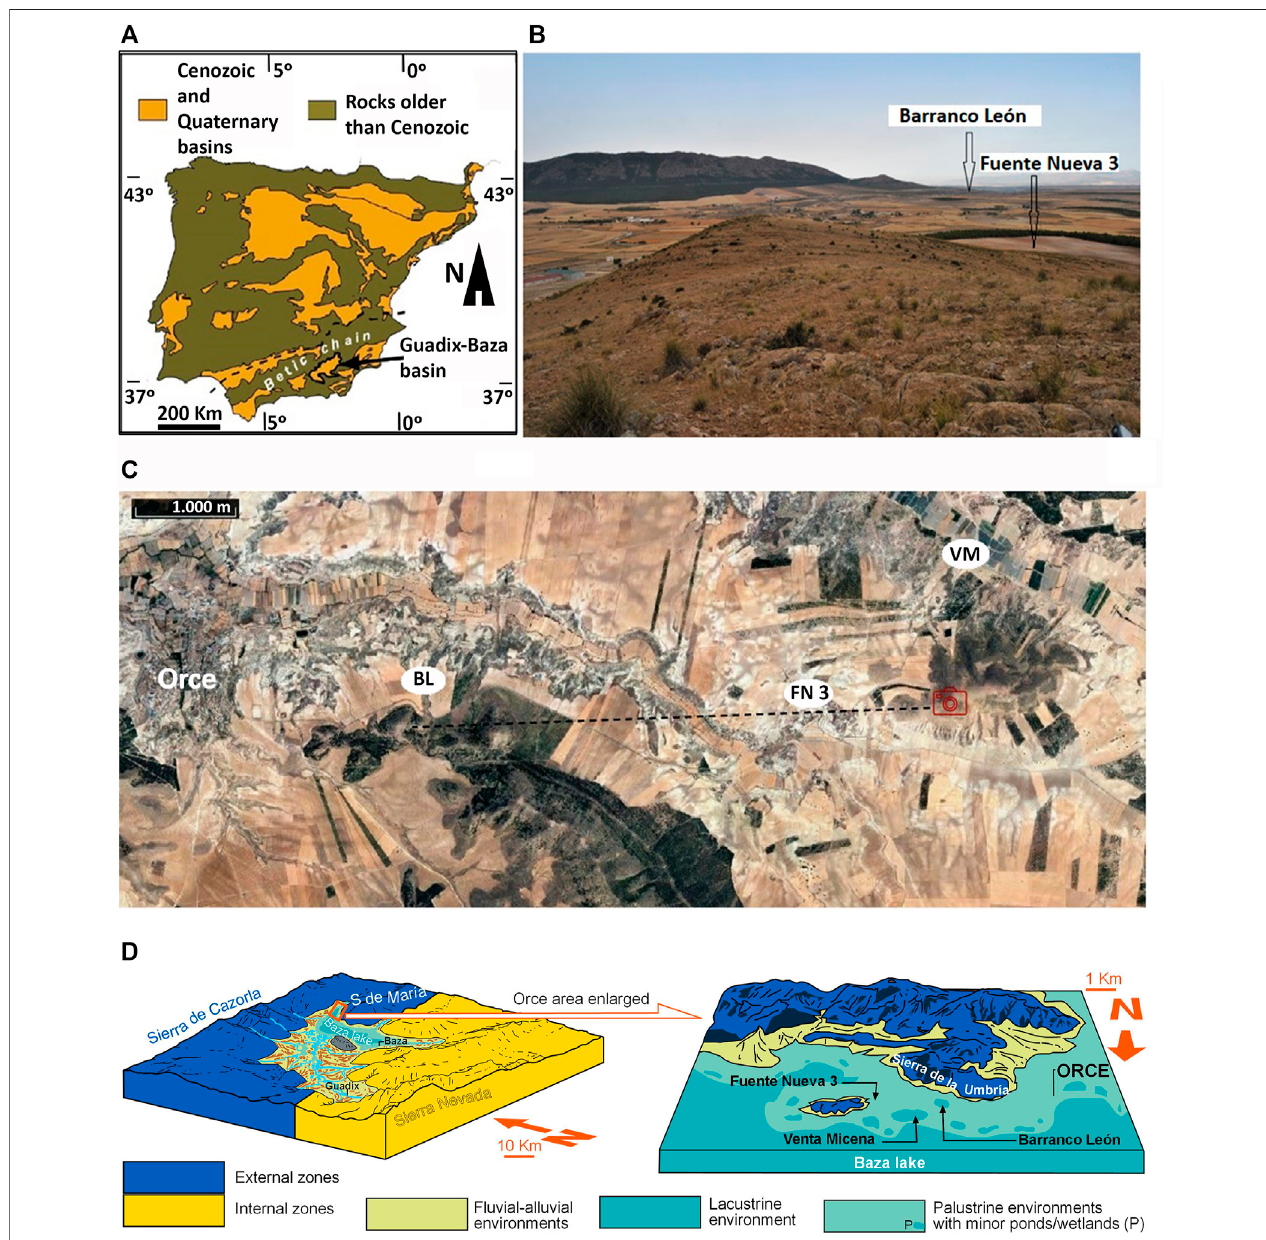
FIGURE1 | (A) Locationof the Guadix-BazaBasin in Spain (image inset) (B) Location of Barranco León and Fuente Nueva 3 with respect tothe slope of theSierra Umbría(Photo:S.Titton) (C) SatelliteviewshowingthelocationoftheBLandFN3inrelationtothevillageofOrce(ImagefromGoogleEarth,Titton,2021).Sitelocations and photograph (B) Capture situation facing BL from the promontory of the Cañada del Campo near FN 3 (D) Geological block diagrams illustrating the context and positioningoftheVentaMicenapaleontologicalsiteandtheOldowansitesofBLandFN3inrelationtothe fl uctuatingshorelineoftheBazapaleolake(adaptedafter Oms et al.,